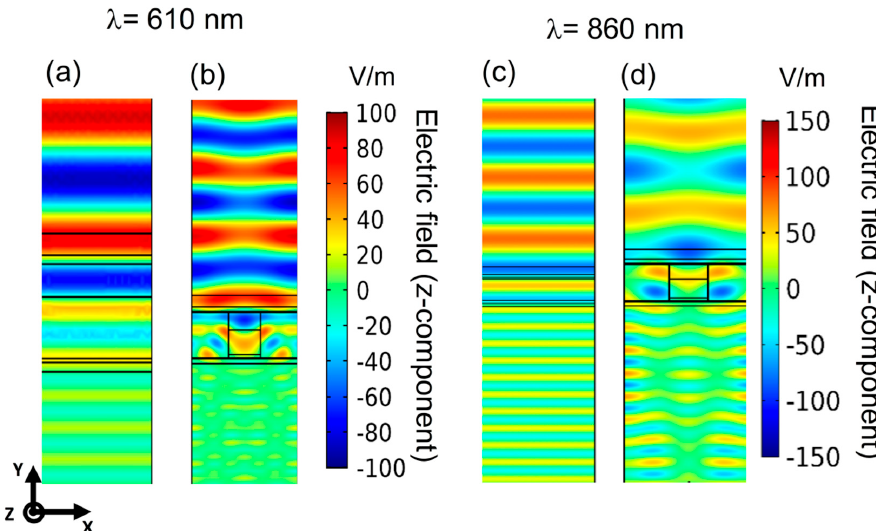
Figure 3. Simulation of the z-component of the total electric field in a monolithic perovskite-silicon tandem solar cell under normal incidence and with a TE polarization considering a planar, ( a ) and ( c ), and the proposed nanostructured configuration, ( b ) and ( d ). While ( a ) and ( b ) uses an incident wavelength in the perovskite absorption range (610 nm), ( c ) and ( d ) are calculated in the silicon absorption range (860 nm).